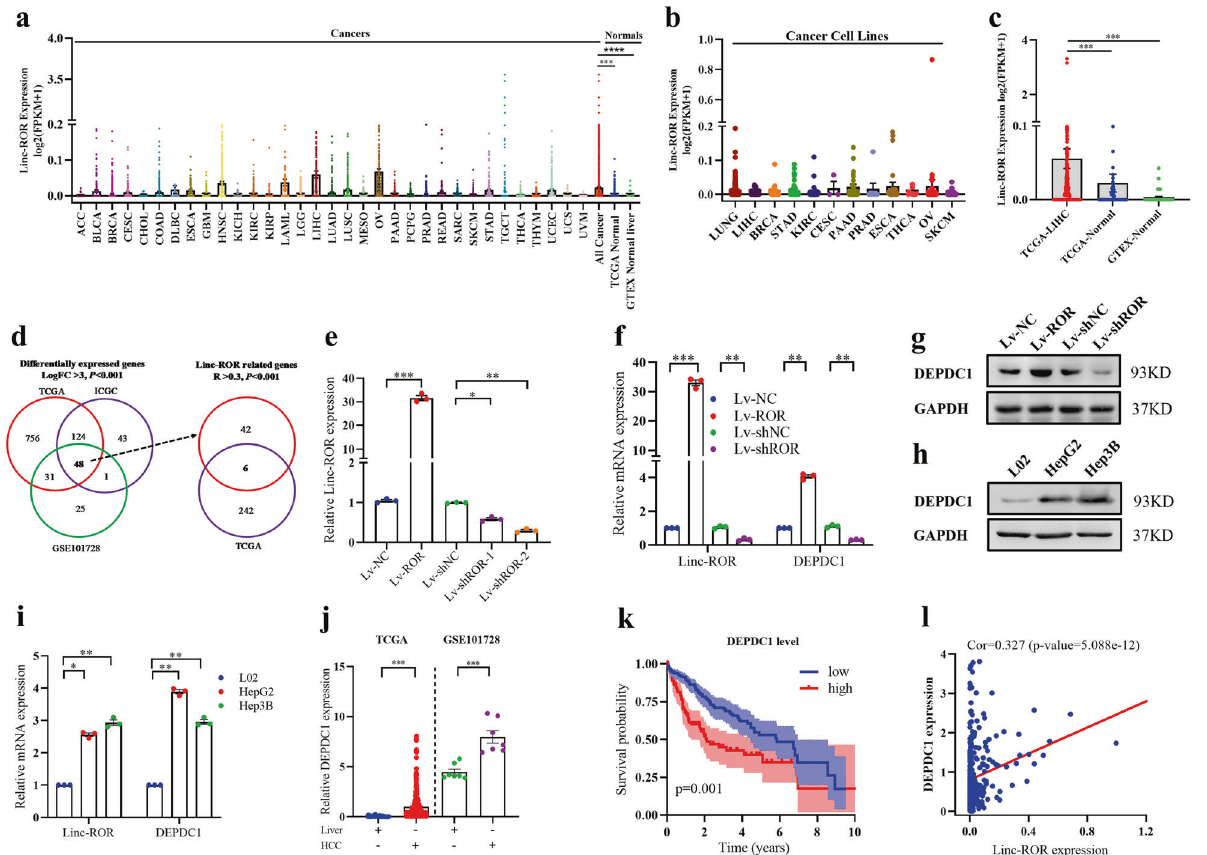
Fig. 1 Linc-ROR was upregulated and regulated DEPDC1 expression. a Expression of Linc-ROR in TCGA tumors and normal tissue samples from GTEx and TCGA. b Expression of THOR in the CCLE cell line panel. c Expression of Linc-ROR in the TCGA Liver hepatocellular carcinoma (LIHC) and matched normal samples and GTEx tissue samples. d Venn diagram showing the screening of Linc-ROR-speci fi c mRNAs. Aberrantly mRNAs were analyzed in liver cancer using the TCGA, ICGC and GSE101728 database. A total of 48 genes were differentially expressed in these three database (LogFC > 3, P < 0.001). These genes are then intersected with the genes co-expressed by Linc-ROR ( R > 0.3, P < 0.001) in the TCGA database. e The overexpression and interference ef fi ciency of Linc-ROR in HepG2 cells were detected using qRT-PCR. f , g The mRNA and protein levels of Linc-ROR and DEPDC1 in HepG2 cells after transfection with overexpression Lv-ROR or interference Lv-shROR. h , i The mRNA and protein expression level of Linc-ROR and DEPDC1 in a normal liver cell line (L02) and HepG2 and Hep3B cell lines were tested by quantitative qRT-PCR. j Expression of DEPC1 in the TCGA and GSE101728 databases. k The overall survival curve in HCC patients with high or low DEPDC1 expression based on TCGA data. l Expression level of Linc-ROR was signi fi cantly correlated with DEPDC1 expression in patients with LIHC of the TCGA database. Data are shown as mean ± SD, n = 3. The data statistical signi fi cance is assessed by Student ’ s t test. * P < 0.05, ** P < 0.01, *** P <